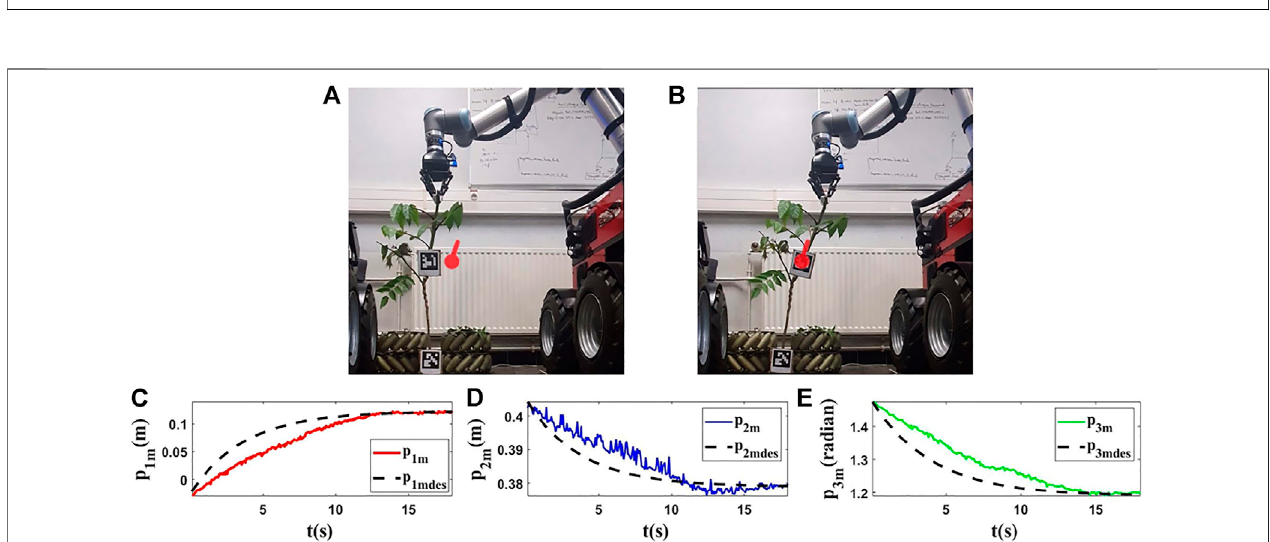
FIGURE14| Experiment5.Firstrow: (A) and (B) aretheinitialand fi nalshapeoftheobject,respectively.Thedesiredstateof m isshownasaredcirclewithasmall line segment. Object ’ s length ( L ) is 0.72( m ). We assume that M 0 is [ − 0.025,0.405,1.480] T and we want to move it to M fdes = [0.123,0.380,1.200] T . The fi nal state of the controlled point is M f = [0.122,0.377,1.197] T . Second row: (C – E) are the evolution of the states in the fi fth experiment with respect to their desired